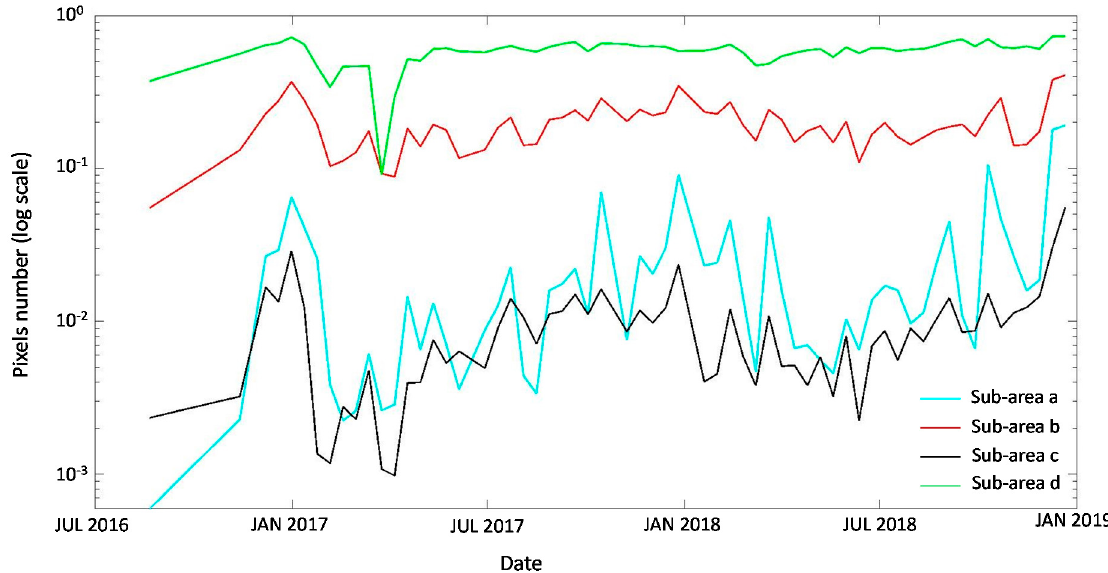
Figure 7. Variation over time of the total number of pixels characterized by a short-term coherence above threshold in the four identified sub-areas of Figure 5. Peaks of stability are detected in winter seasons in sub-areas a and c .